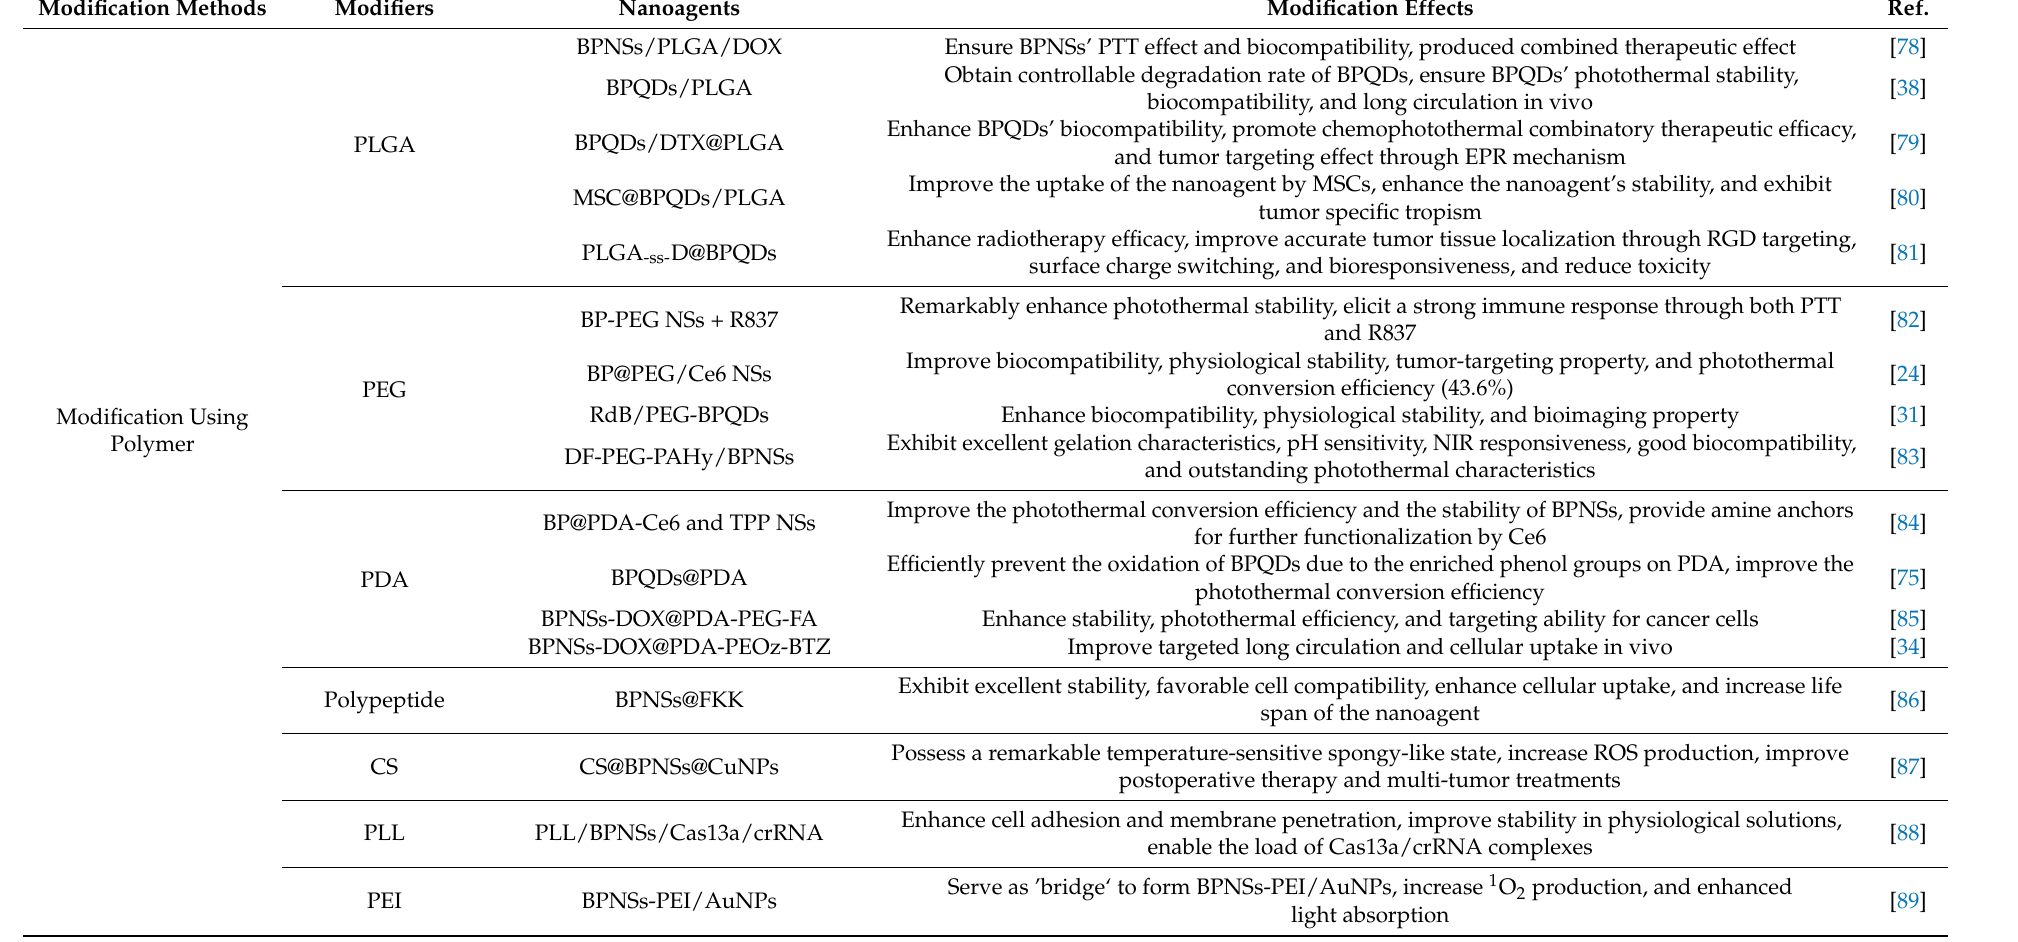
Table 2. Examples of various physical modification methods to BP